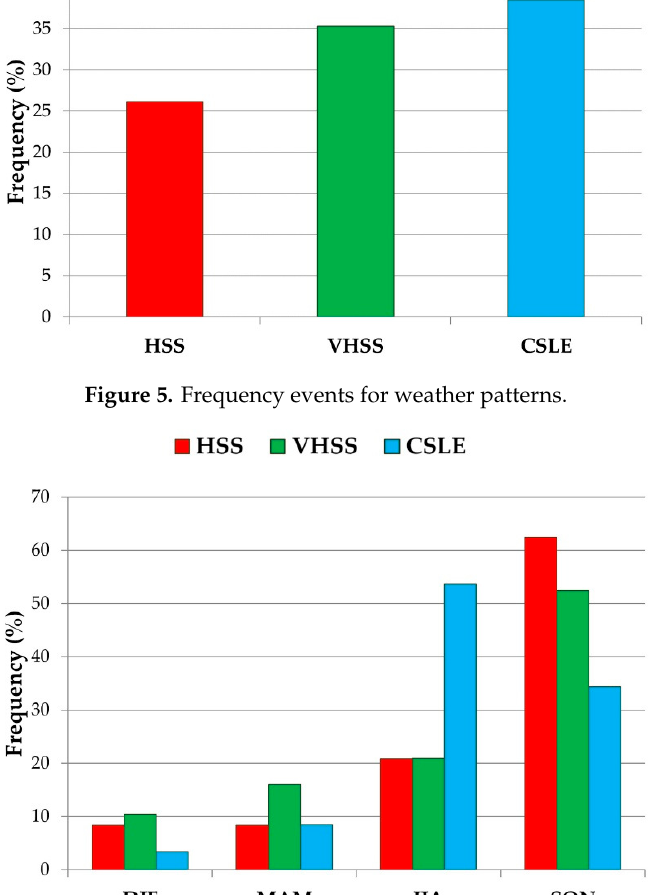
Figure 6. Seasonal frequency histograms of the Heavy Synoptic System (HSS), Very Heavy Synoptic System (VHSS) and Convective Systems with Local Effects (CSLE).